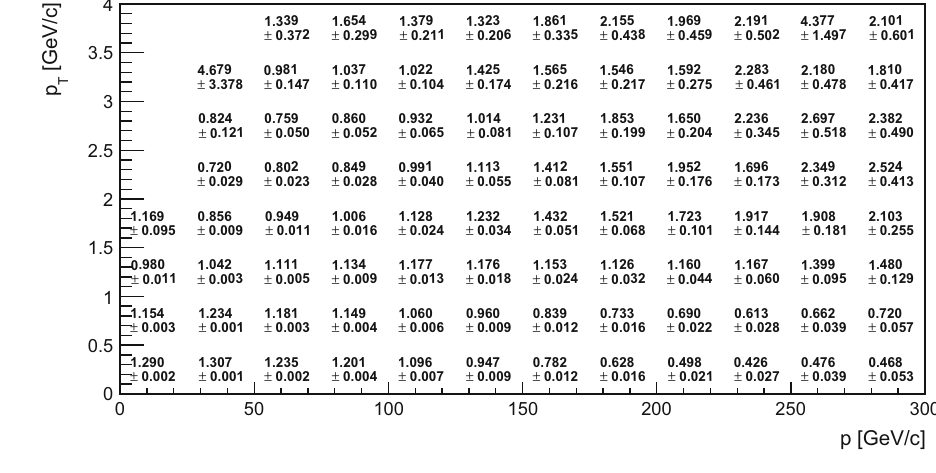
Fig. 9 Ratio of data and MC tracks, R = N data in bins of p N MC and p